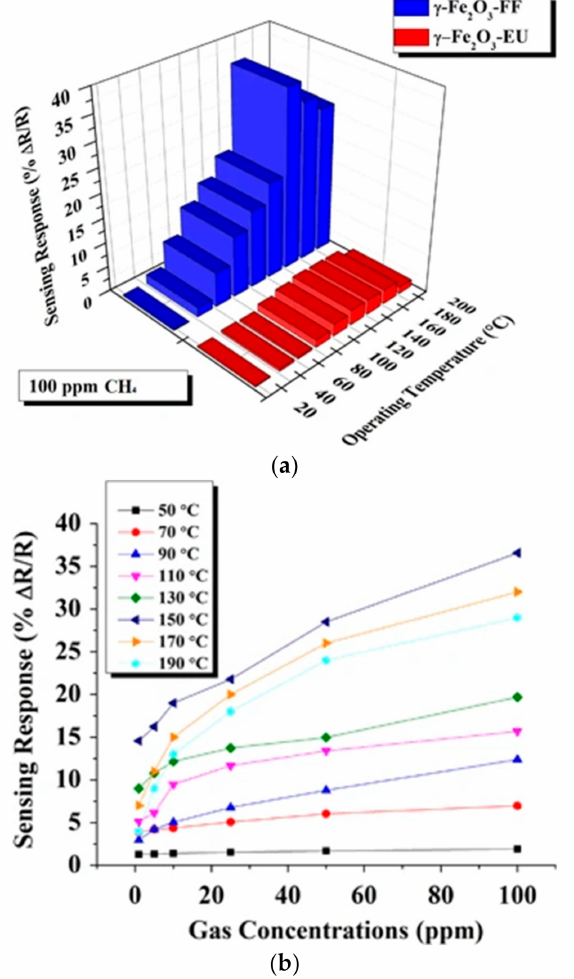
Figure 21. The gas response of the γ -Fe 2 O 3 –EU and γ -Fe 2 O 3 –FF NPs: ( a ) towards 100 ppm of CH 4 as a function of working temperature (25–190 ◦ C); ( b ) responses of the γ -Fe 2 O 3 –FF versus gas concentrations. Reprinted from Ref. [104] with permission of Springer Science Business Media, LLC,